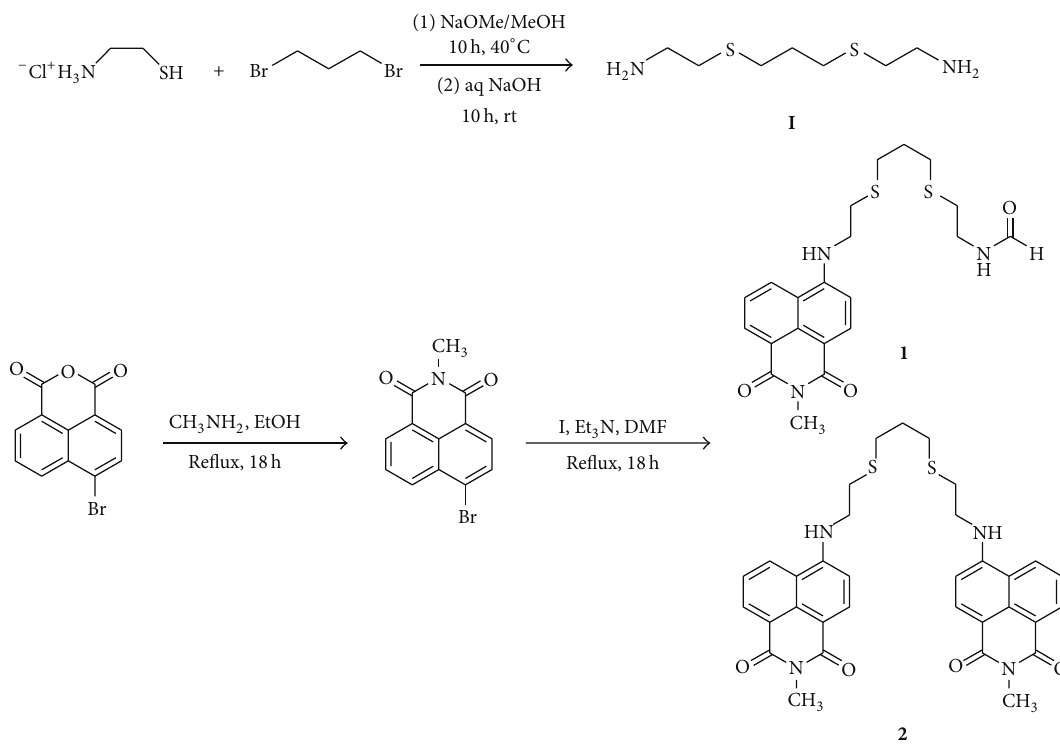
Scheme 1: Syntheses of fluorescence sensors 1 and 2